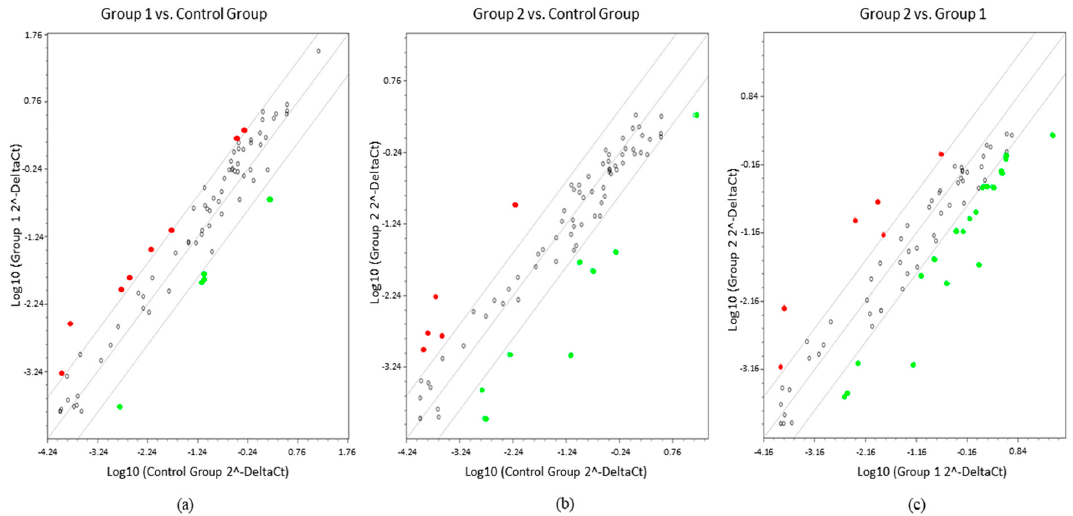
Figure 2. Scatter plots showing comparisons between groups. ( a ) ULM (group 1) compared with MM (control group); ( b ) ULMS (group 2) compared with control group; ( c ) Group 1 compared with group 2 (FC expression cut-off values of +4 and − 4). In red, overexpressed miRNAs and, in green, underexpressed miRNAs.